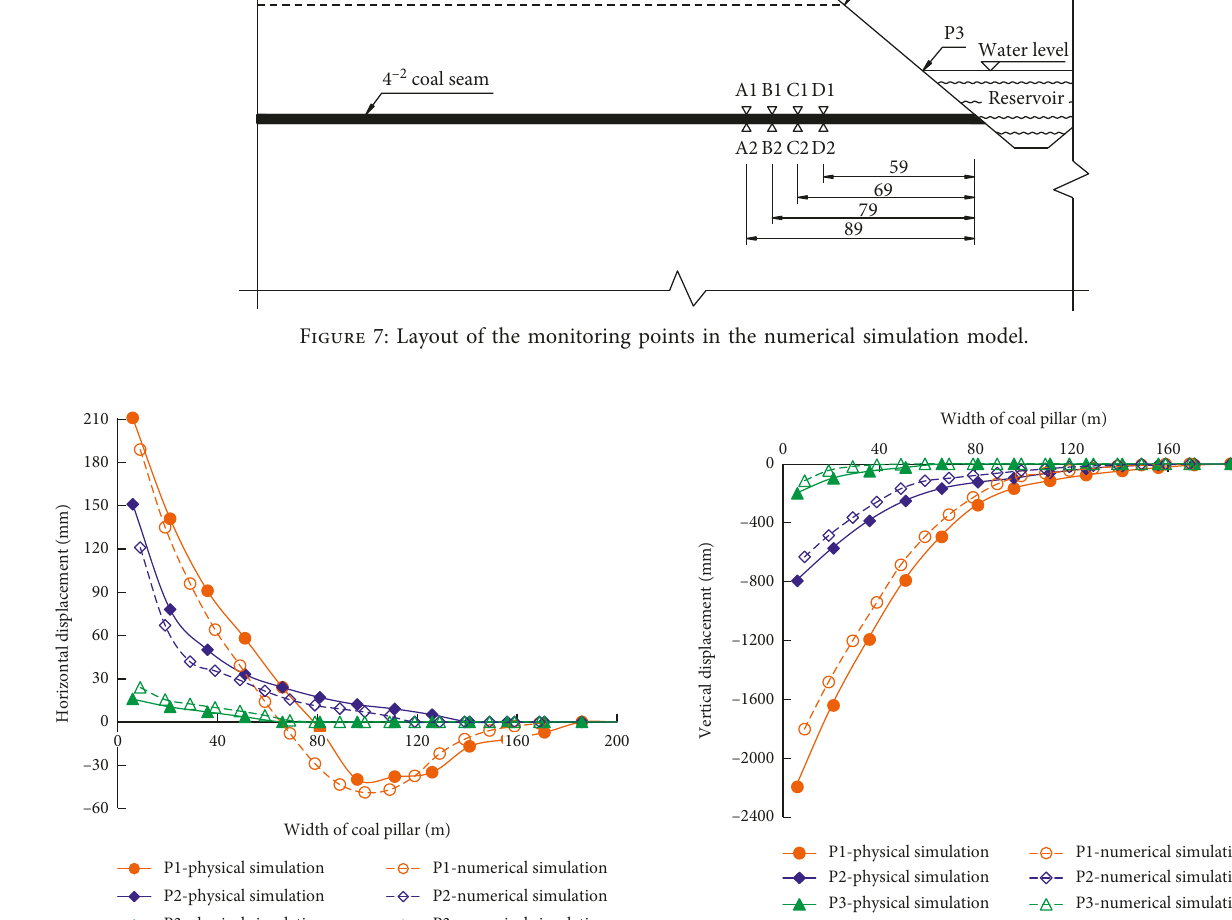
Figure 9: Variations in the vertical displacements of the moni- toring points with the coal pillar width.